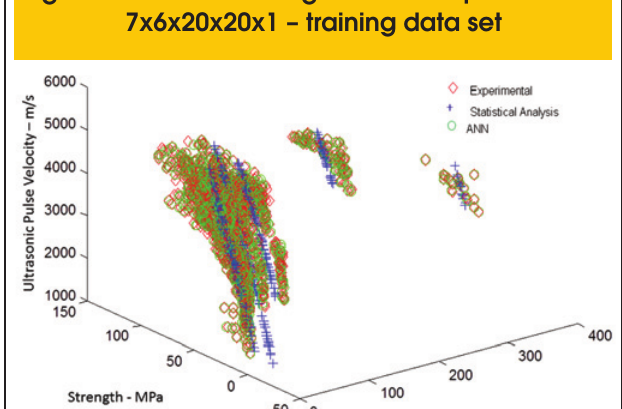
Figure 16 – UPV x fc x age relationship – network 7x6x20x20x1 – training data set